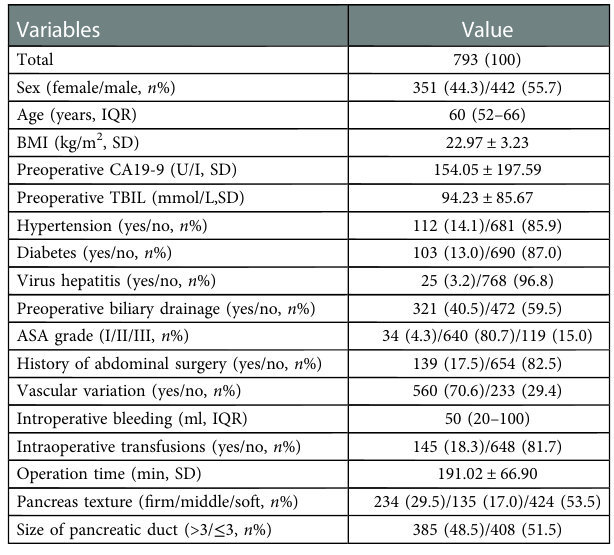
TABLE 1 Baseline characteristics of the study